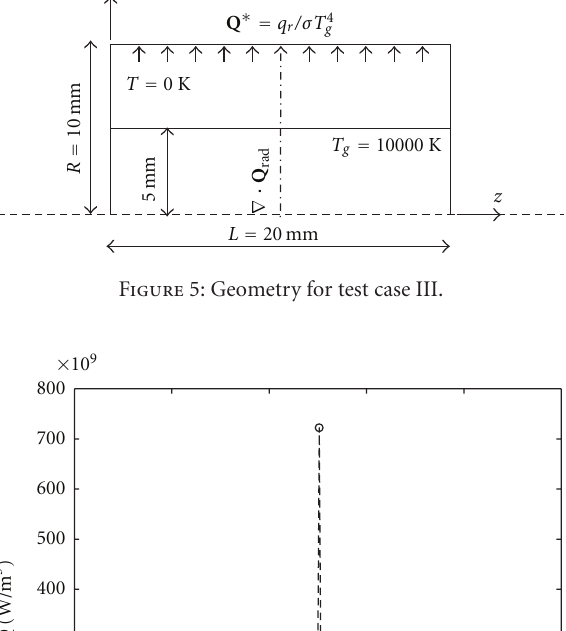
two types of bands: